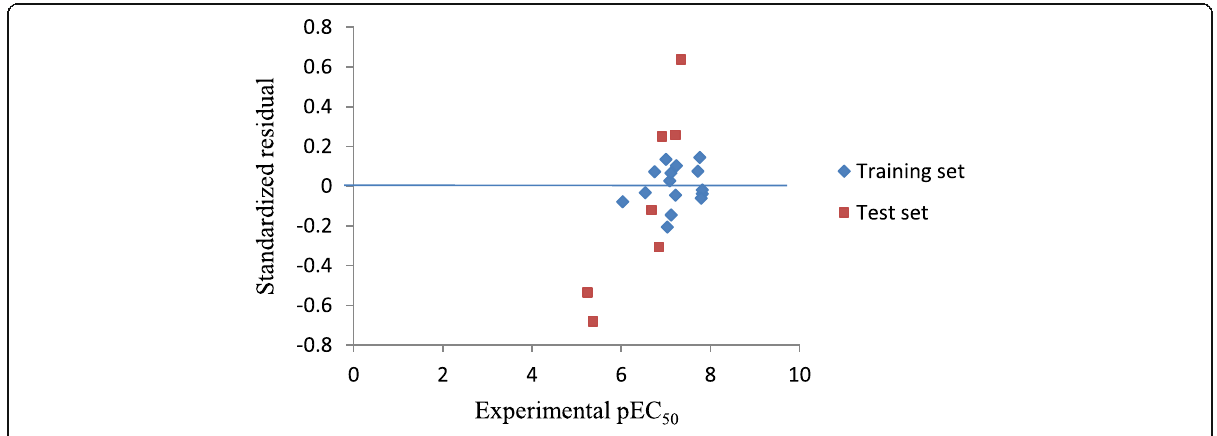
Fig. 2 Plot of standardized residual activity against experimental activity